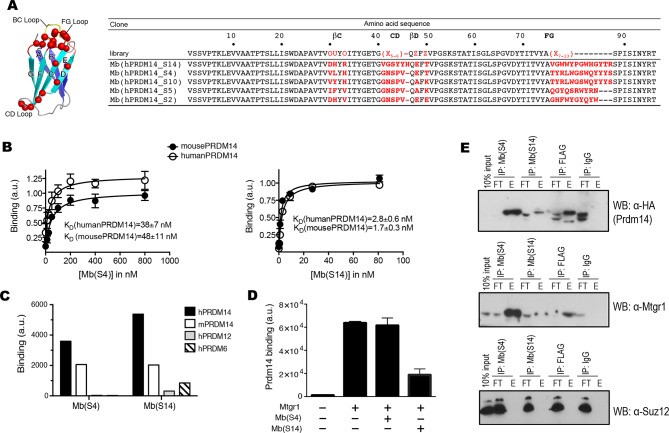
Generation of PRDM14-binding monobodies.(A) Schematic of the monobody scaffold. The β strands and loops are labeled and the diversified residues are marked as red spheres. The amino acid sequences of the monobody library and monobody clones. In the library designs, ‘X’ denotes a mixture of 30% Tyr, 15% Ser, 10% Gly, 5% Phe, 5% Trp, and 2.5% each of all the other amino acids except for Cys; ‘O’, a mixture of Asn, Asp, His, Ile, Leu, Phe, Tyr, and Val; ‘U’, a mixture of His, Leu, Phe, and Tyr; ‘Z’, a mixture of Ala, Glu, Lys, and Thr (Koide et al. 2012). A hyphen indicates a deletion. (B) Titration curves of Mb(hPRDM14_S4) and Mb(hPRDM14_S14) to human PRDM14 and mouse Prdm14. The error bars are the standard deviation (n = 3). The curves show the best fit of the 1:1 binding model. (C) Binding of Mb(S4) and Mb(S14) expressed on yeast surface to 50 nM of hPRDM14 and its homologues, mouse Prdm14, human PRDM12 and human PRDM6. (D) Competitive binding assay for Mtgr1 and monobodies. Binding of 10 nM Mtgr1 to biotinylated Prdm14 immobilized on streptavidin coated M280 beads in the absence and presence of 500 nM purified monobodies, Mb(S4) and Mb(S14). (E) Co-immunoprecipitation of FLAG–HA tagged Prdm14 expressed in mESC using Mb(S4), Mb(S14), α-FLAG M2 antibody or a negative control antibody (‘IgG’). Antibodies used for Western blotting are indicated with the blots. E, elution; FT, flow through; Mtgr1, myeloid translocation gene related 1.